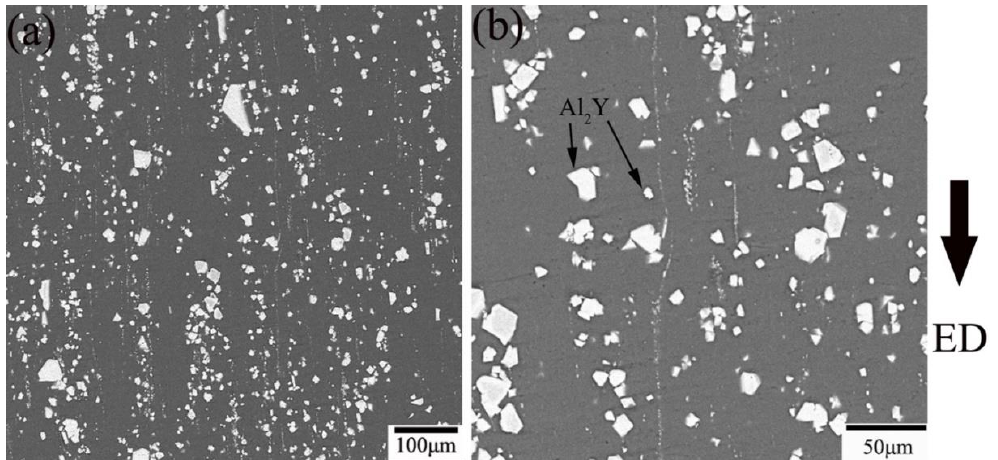
Figure 7. BSE-SEM images of the as-extruded YA65 alloy: ( a ) low magnification; ( b ) high magnification.